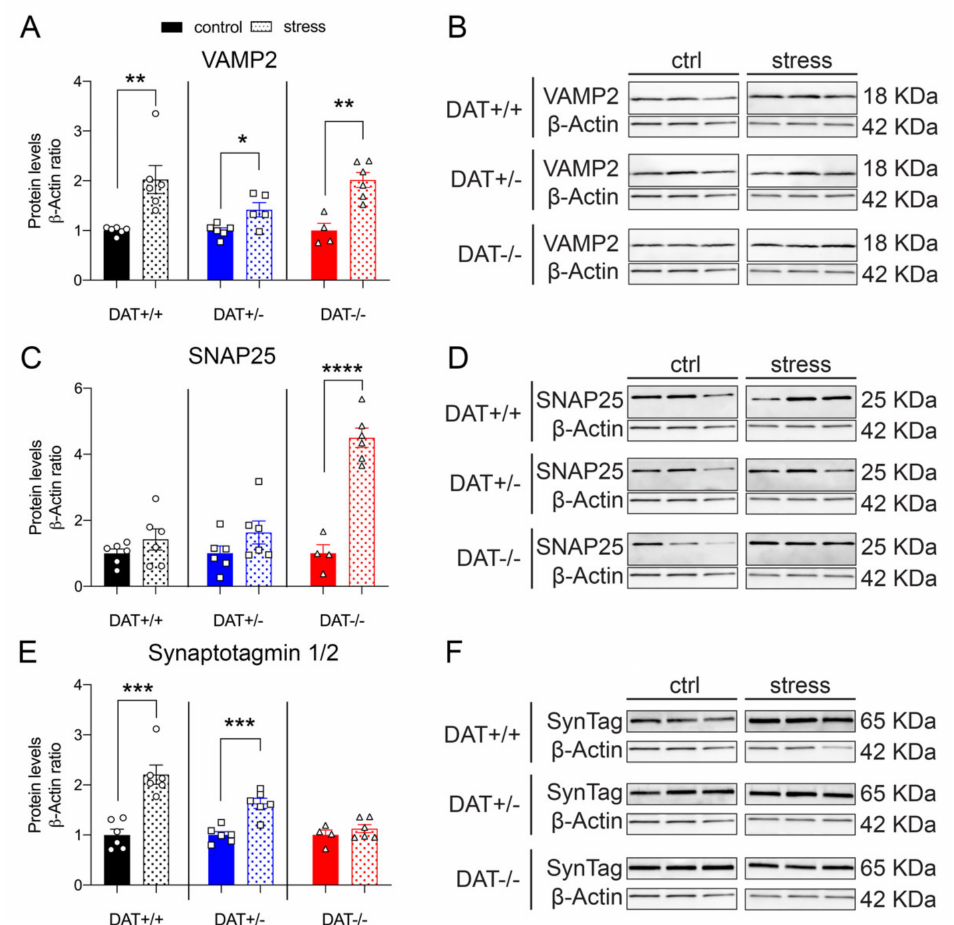
Figure 7. Restraint stress e ff ects on the exocytotic machinery of the pituitary gland in female rats lacking DAT. ( A ) Exposure to restraint stress significantly increased VAMP2 in all genotype conditions. ( C ) Restraint stress increased SNAP25 protein levels only in DAT- / - rats. ( E ) Increased levels of synaptotagmin 1 / 2 protein were found in DAT +/+ and DAT +/ - rats after stress, but no changes were detected in DAT- / - rats. ( B , D , F ) Immunoblots from representative rats in each group are shown. Data were normalized to β -actin. For each genotype, data were expressed as relative to basal (non-stress) conditions. Data are expressed as mean ± SEM ( n = 4–6), * p < 0.05, ** p < 0.01, *** p < 0.001. **** p <